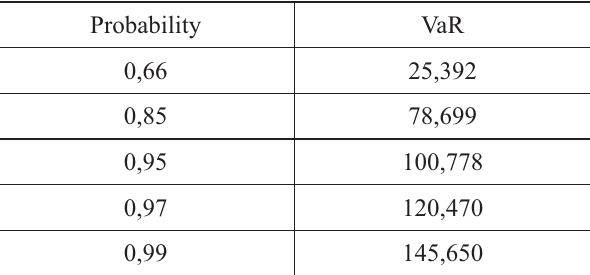
Table 3. VaR values with different notions of “p”